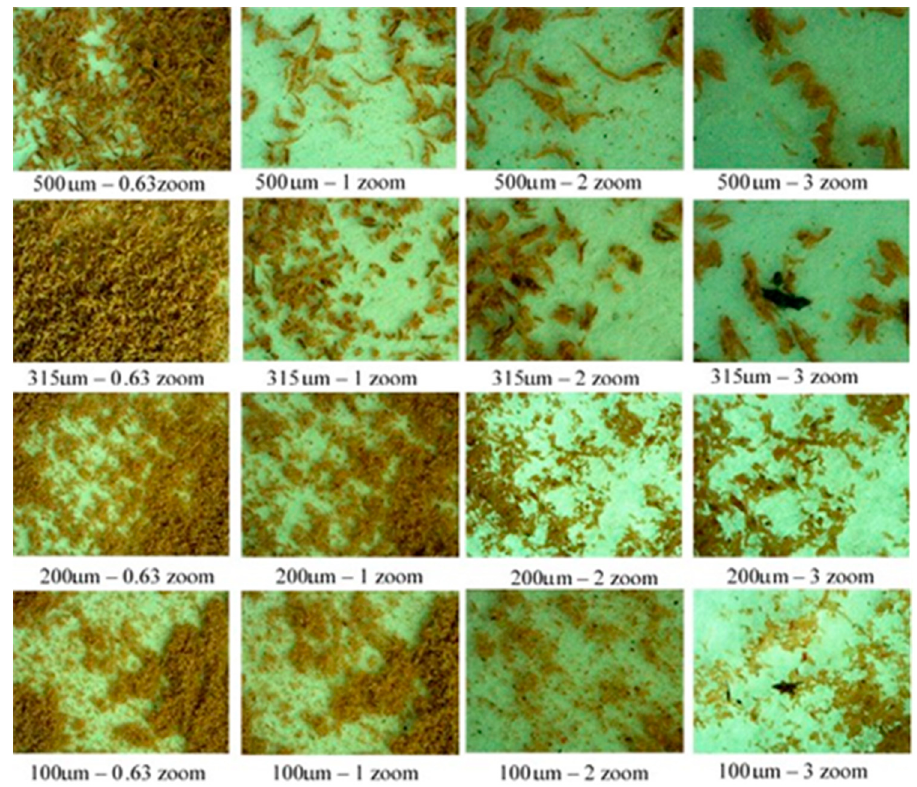
Figure 3. Cumaru dust particles and their shape.